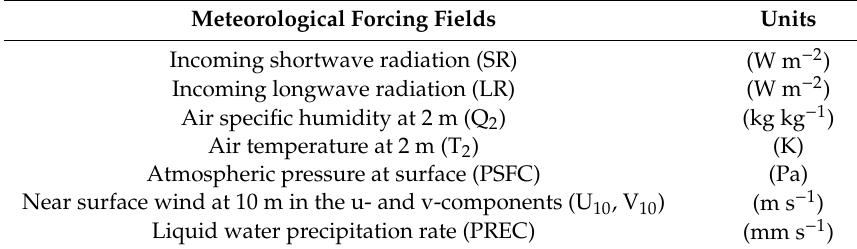
Table 1. The seven meteorological forcing fields [16].